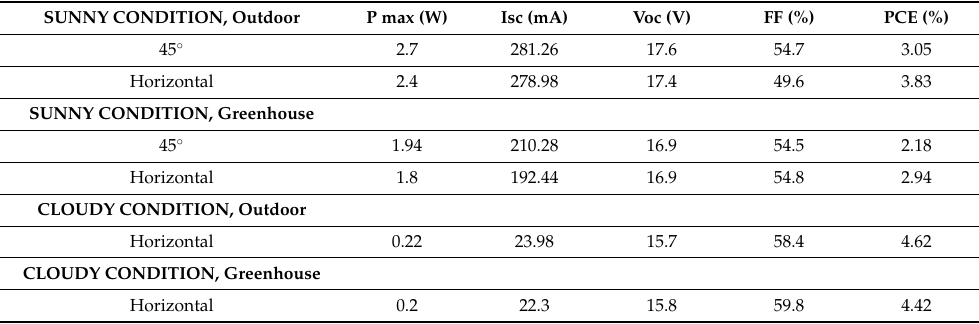
Table 3. Electrical parameters of the DSSC panel at different meteorological conditions and environ- ments. Panel’s active area: 886 cm 2